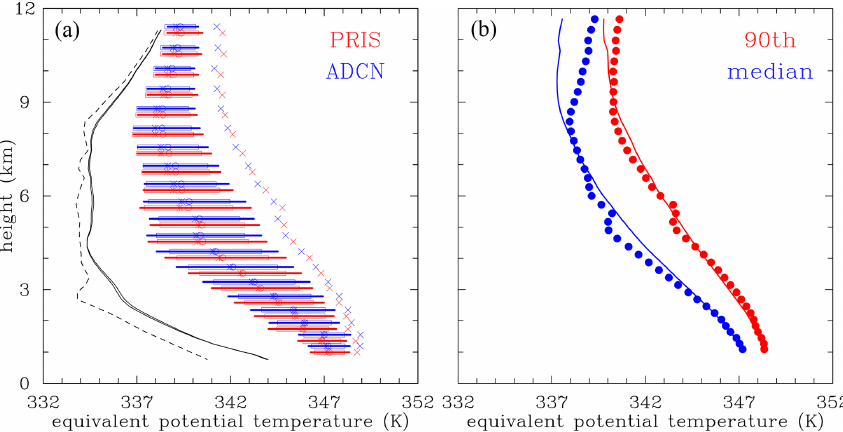
Figure 4. (a) Comparison of equivalent potential temperature statistics during the 6th and 7th hours from GM20 PRIS (red) and ADCN (blue) simulations. Asterisks represent median values, thick lines mark the range between the 10th and 90th percentiles, circles show the mean values, and “x” symbols to the right of the boxes represent means of the range between the 90th percentile and the maximum. Boxes represent the range between the mean and plus and minus 1 standard deviation. Only in-cloud points with vertical velocity larger than 1ms − 1 and total condensate larger than 1gkg − 1 are included in the statistics. The dashed black line is the equivalent potential temperature profile calculated from the initial sounding. The two solid lines are the equivalent potential temperature profiles calculated from the mean temperature and moisture profiles averaged over the 6th and 7th hours from PRIS and ADCN ensemble simulations. (b) Comparison between model and entraining parcel results. Dots are median (blue) and 90th percentile (red) values from the PRIS results in (a) . Lines are profiles of the equivalent potential temperature derived from the entraining parcel with the constant entrainment rate that minimizes the difference between the parcel and either the median or the 90th percentile profile from the model between 1 and 10km. See text for more